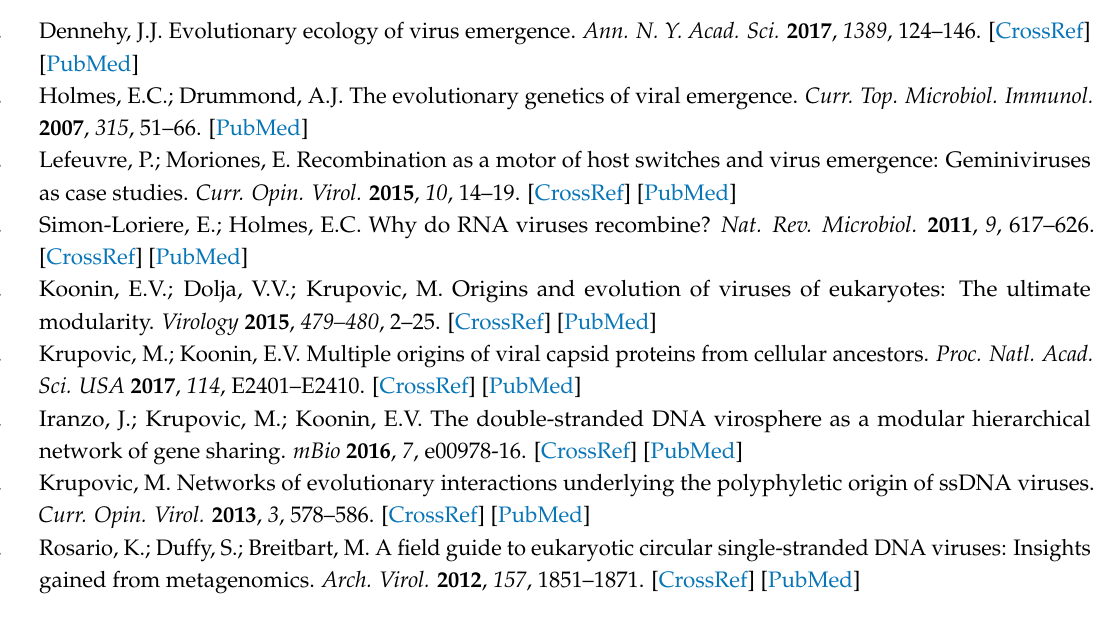
Supplementary file 1: List of Rep proteins analyzed in this study, Figure S1: Phylogenetic tree of all CRESS DNA viruses based on full-length Rep amino acid